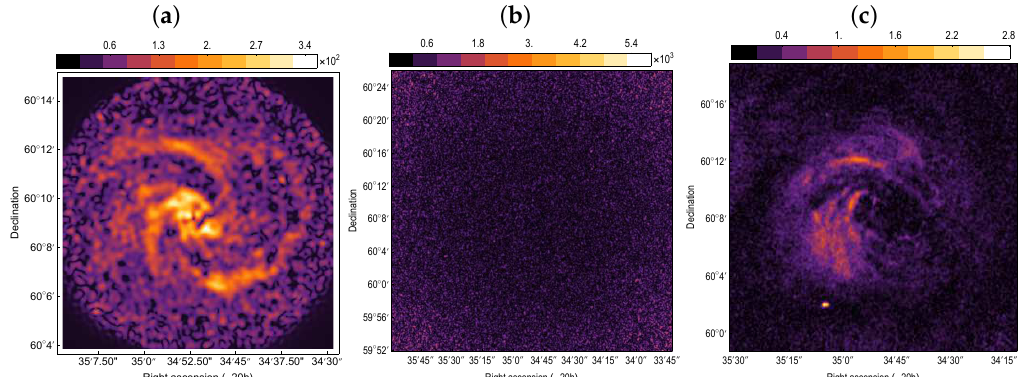
Figure 1. ( a ) Polarized intensity distribution in NGC 6946 at λ = 6, ( b ) single narrowband channel at λ = 20cm, and ( c ) peak Faraday spectra F max synthesised from λ = 17–22cm. All are measured with µ Jy/beam. Note the different colour scale in each